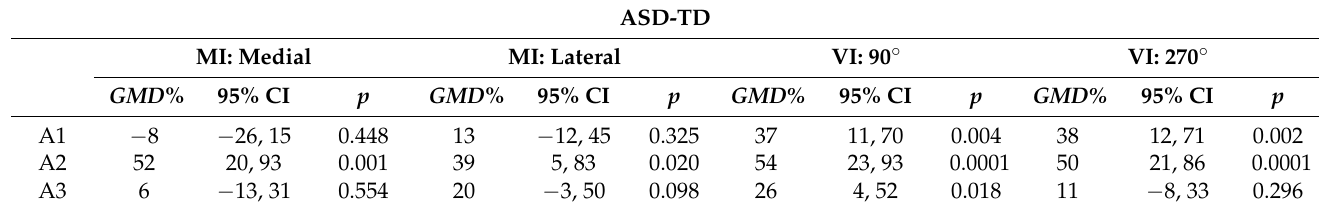
Table 6. Between group effects of the medial, lateral, 90 ◦ and 270 ◦